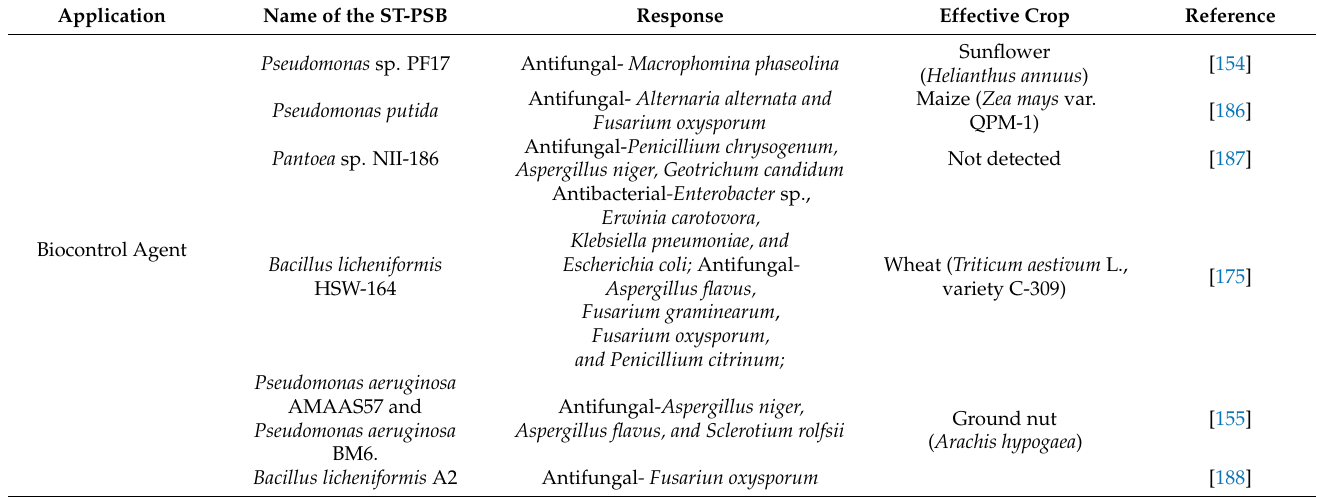
Table 3. Application of salt-tolerant PSB in sustainable saline